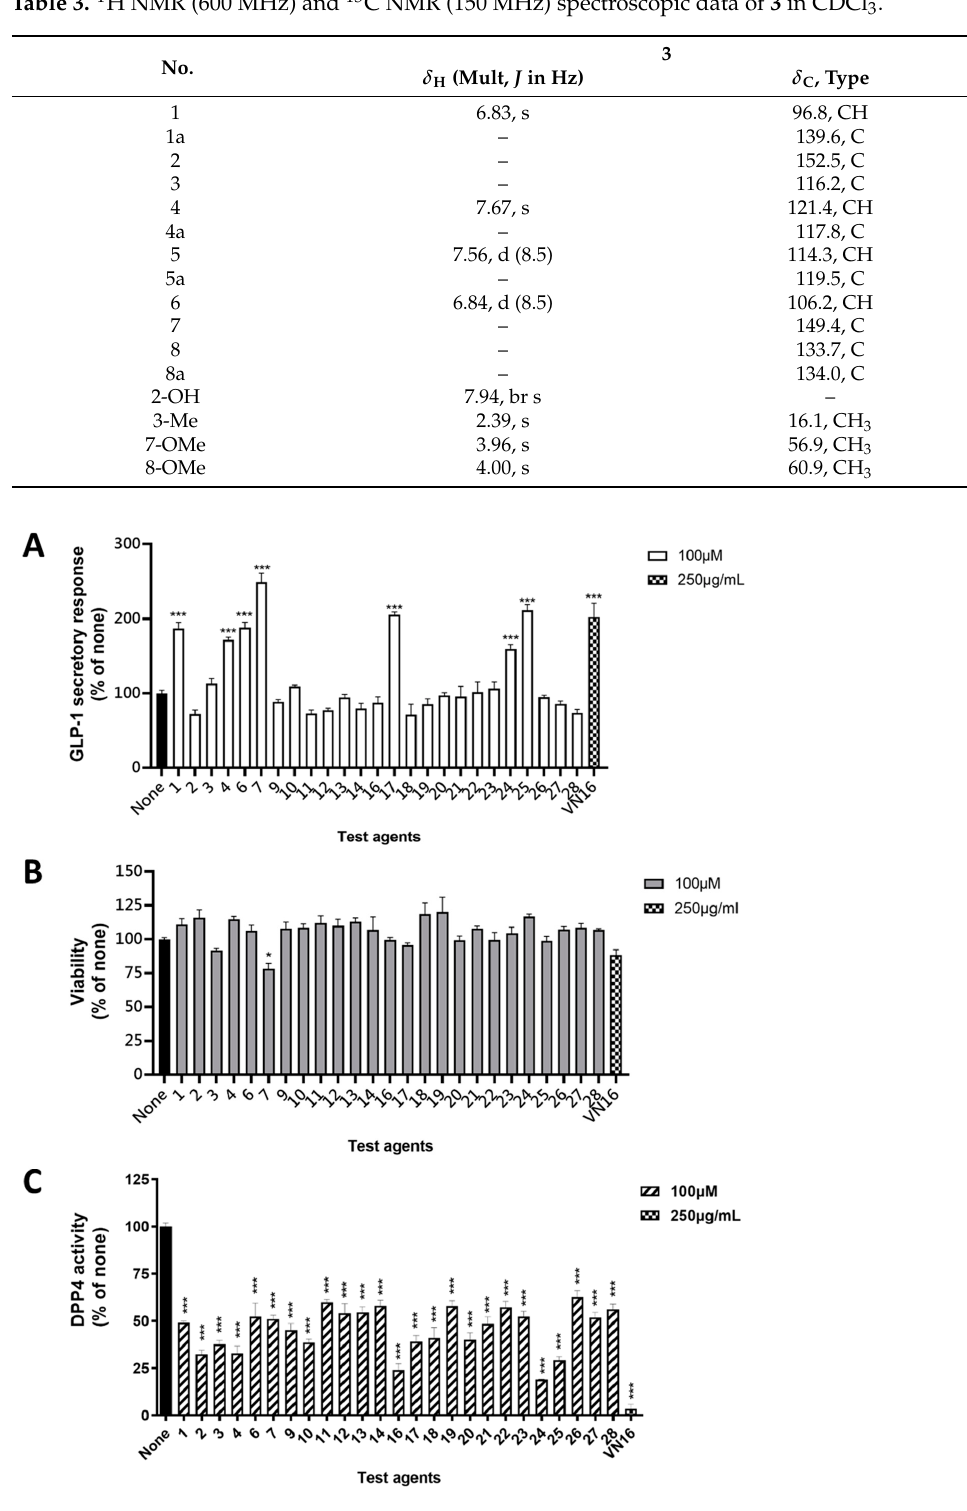
Figure 4. The anti-diabetes effect of isolated compounds in STC-1 cells. ( A ) GLP-1 secretory effects of the methanol layer of G. pentaphylla (VN16) and isolated compounds. ( B ) Acute toxicity evaluation of the methanol layer of G. pentaphylla (VN16) and isolated compounds in STC-1 cells. ( C ) The effects of the methanol layer of G. pentaphylla (VN16) and isolated compounds on DPP4. Data represent mean ± SEM ( n = 3–4). Ordinary one-way ANOVA with Dunnett ′ s multiple comparisons test. * p < 0.05, *** p < 0.001 when compared to None.